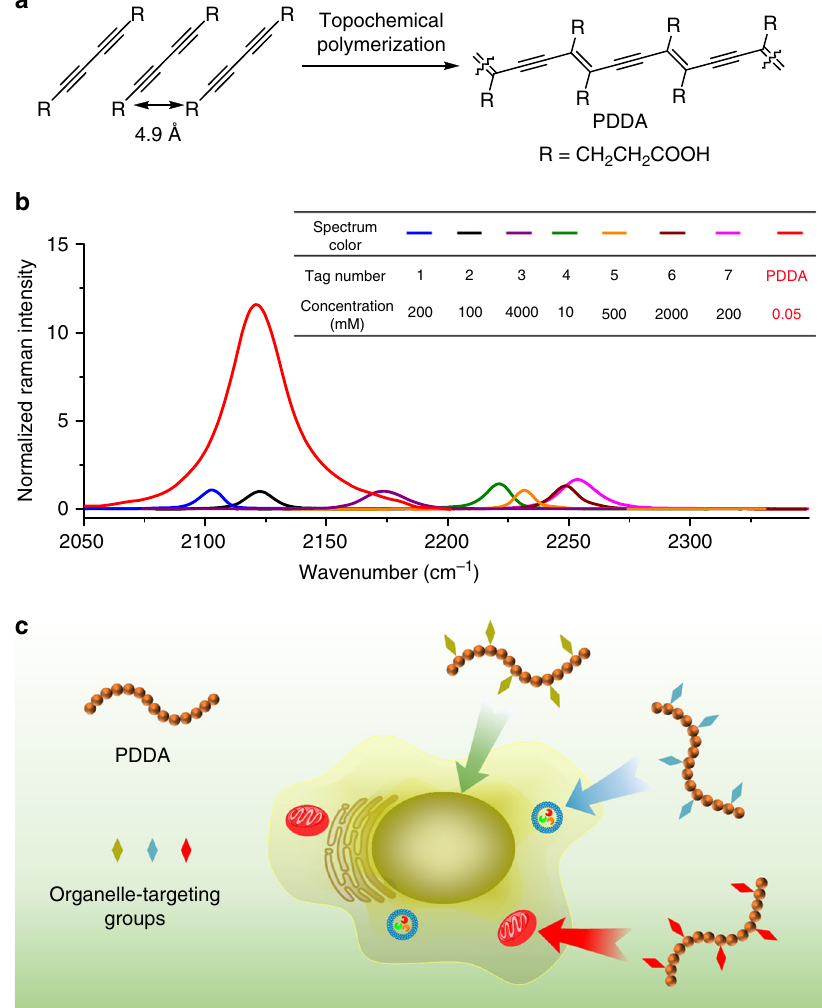
Fig. 1 Polydiacetylene-based Raman probes for targeted live-cell Raman imaging. a Topochemical polymerization for the preparation of PDDA. b Overlaid Raman spectra of individual DMSO solution of PDDA and a series of representative Raman probes, including 1. ethynylbenzene; 2. EdU; 3. diphenyl phosphorazidate; 4. diphenylbutadiyne; 5. benzonitrile; 6. 5-bromopentanenitrile; 7. deca-4,6-diynedioic acid. The probe structures are shown in Supplementary Fig. 1. The table inset lists the concentration of Raman-active bonds (C ≡ C, C ≡ N, or azide) in each solution. The normalization is based on the absolute Raman intensity of each spectrum. c Schematic illustration of side chain modi fi cation of PDDA for subcellular organelle targeting Raman